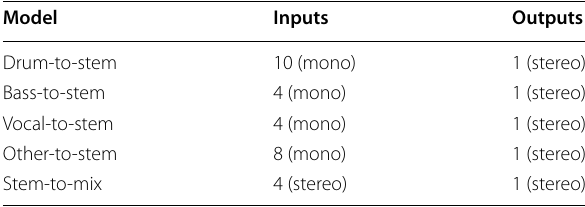
Table 1 Models and number of inputs and